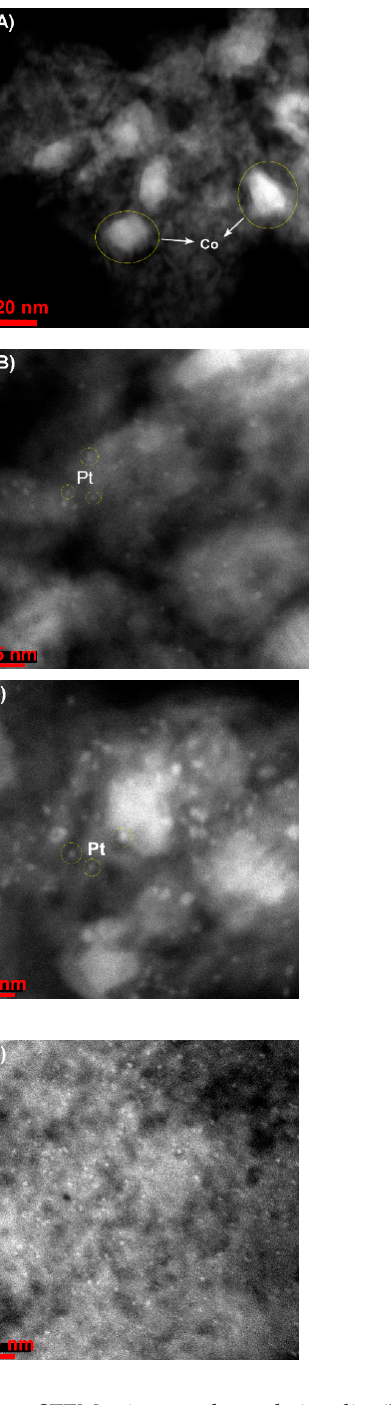
Figure 3. STEM micrographs and size distribution histogram of the reduced samples: ( A ) CoAl, ( B ) 0.3Pt/CoAl, ( C ) 1Pt/CoAl and ( D ) 0.3Pt/Al.